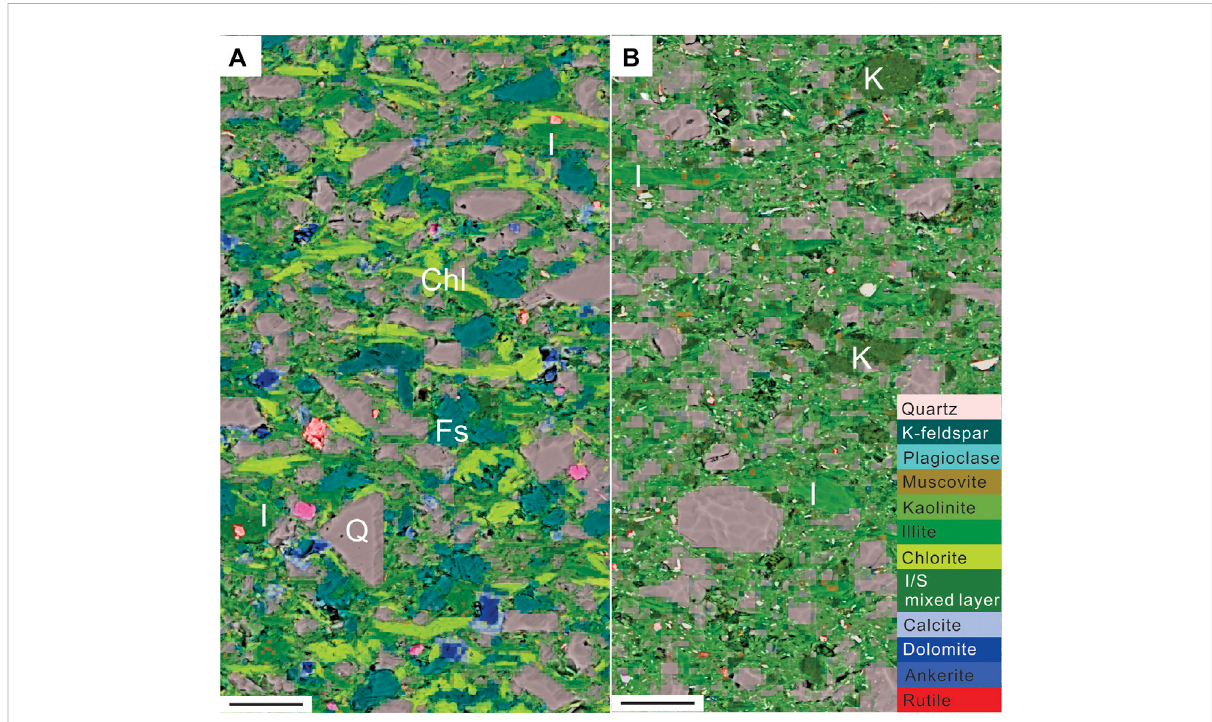
FIGURE 8 Representative petrographic imagesof theCryogenian Enorama Shale (A) and the mid Ediacaran Bunyeroo Formation (B) . Scale bars represent 20 μ m. Minerals in Enorama Shale are mostly products of physical weathering (e.g., (sub)angular quartz and feldspar; coarse chlorite fl akes), while minerals in Bunyeroo Formation show distinct features of pedogenic origin (e.g., patches of fi ne, randomly oriented illitic clays), arguing to intense chemical weathering. The enhanced chemical weathering from Cryogenian to mid Ediacaran could be mediated by expansion of terrestrial biomass during the Ediacaran Period (Ra fi ei et al.,